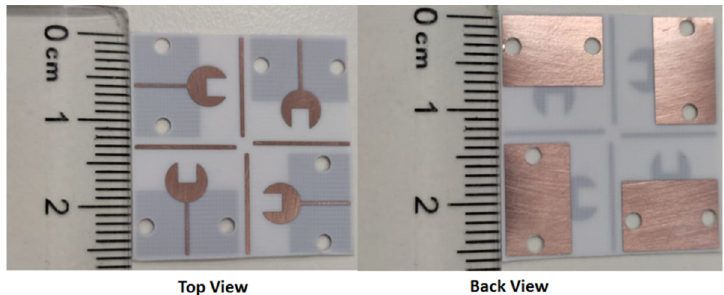
Figure 10. The surface current distribution at 38 GHz ( a ) without stubs ( b ) with stubs.